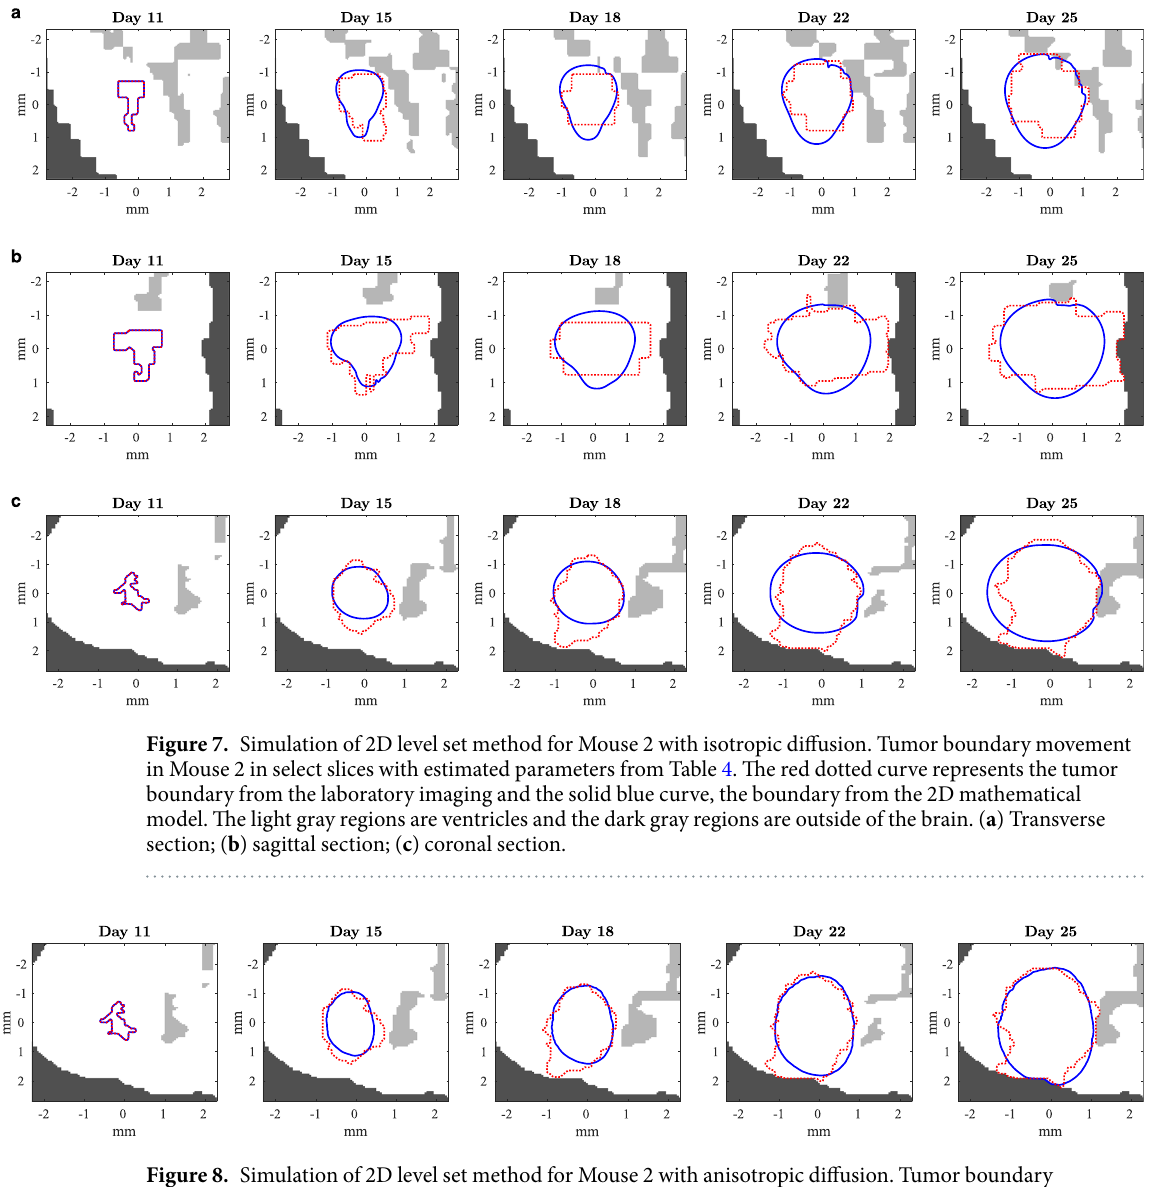
Figure 8. Simulation of 2D level set method for Mouse 2 with anisotropic diffusion. Tumor boundary movement in Mouse 2 in the same slice as Fig. 7(c) but with a spatially dependent value of the diffusion parameter D . Solid blue curve: numerical simulation; dotted red curve: actual tumor boundary. The light gray regions are ventricles and the dark gray regions are outside of the